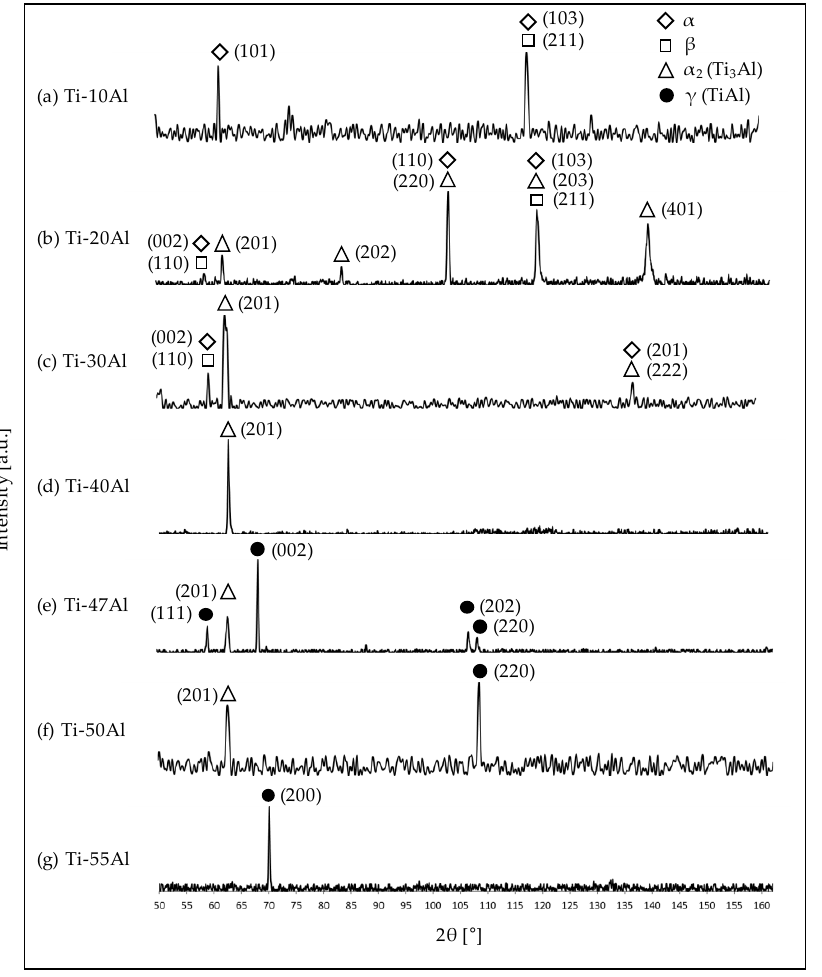
Figure 7. Di ff ractogram for Ti–Al alloys with di ff ering aluminum content; ( a ) 10 at%, ( b ) 20 at%, Figure 7. Diffractogram for Ti – Al alloys with differing aluminum content; (a) 10 at%, (b) 20 at%, (c) ( c ) 30 at%, ( d ) 40 at%, ( e ) 47 at%, ( f ) 55 30 at%, (d) 40 at%, (e) 47 at%, (f) 55 at%.